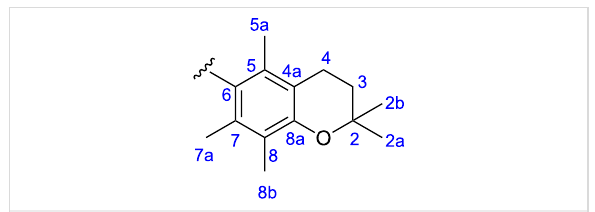
Figure 4: Numbering of carbon atoms in the chromanyl moiety.